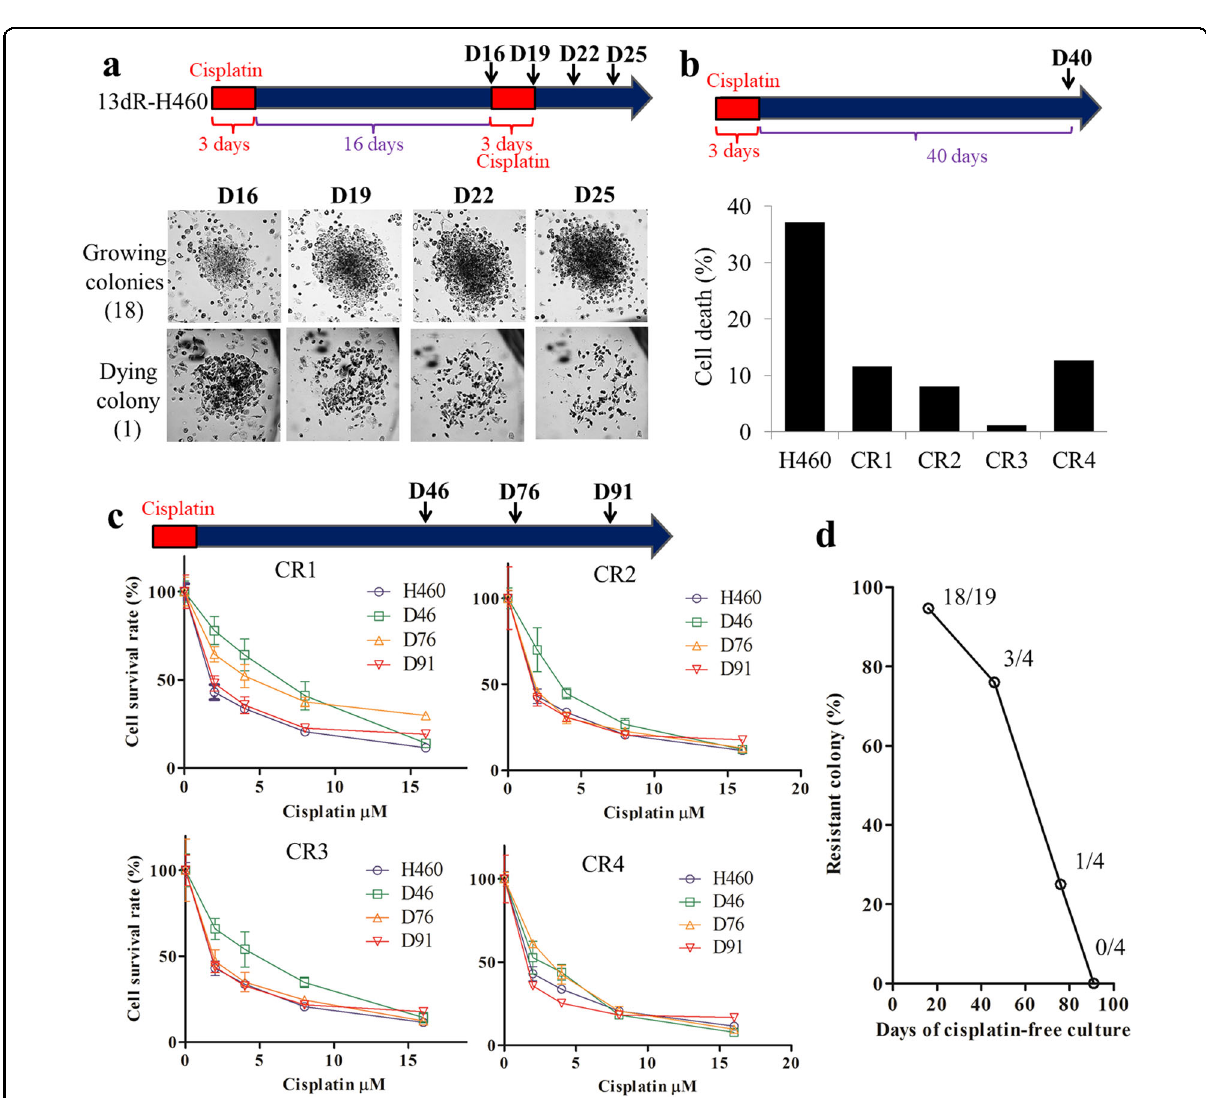
Fig. 2 Medium-term maintenance of drug resistance in cisplatin-resistant (CR) 13dR-H460 clones. a Maintenance of cisplatin resistance in CR 13dR-H460 colonies under cisplatin-free culture until day 16. After the cisplatin treatment of 13dR-H460 cells, the 19 resistant colonies were marked with a pen on day 16 and were monitored by taking pictures on days 16, 19, 22, and 25 (marked as D16, D19, D22, and D25, respectively). Almost all of the resistant colonies (94.7%, 18/19) maintained cell growth or cisplatin resistance. b Maintenance of cisplatin resistance under cisplatin-free culture for 40 days (D40). Relative cell death was monitored by Annexin V staining with and without cisplatin treatment (5 μ M) in 4 isolated CR 13dR- H460 colonies (CR1, CR2, CR3, and CR4) under cisplatin-free culture for 40 days. Only one experiment was performed. c Determination of cisplatin resistance (IC 50 ) on days 46 (D46), 76 (D76), and 91 (D91) after selection for cisplatin resistance. The IC 50 for cisplatin was determined in CR 13dR-H460 colonies along with the parental H460 cells. The Y -axis, cell survival rate (%). The X -axis, cisplatin concentration ( μ M). d Plot of the decrease in